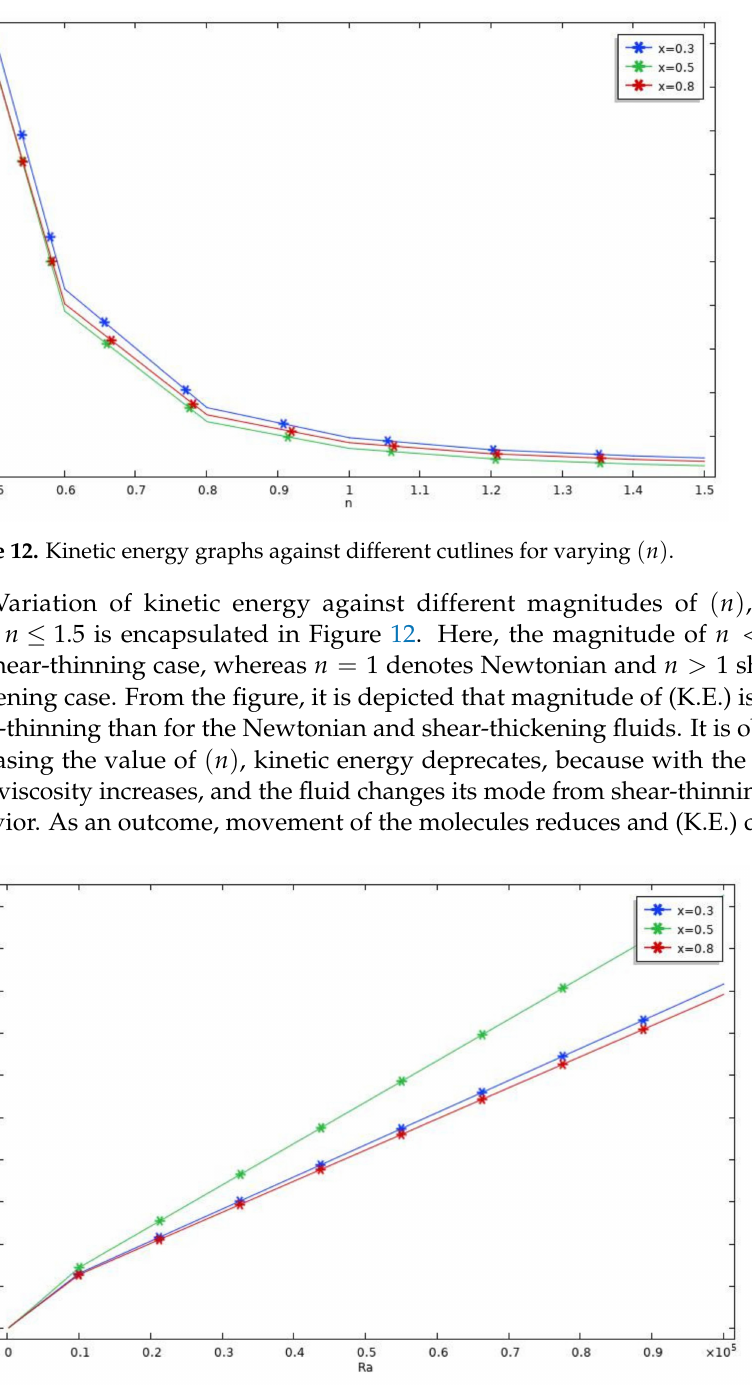
Figure 13. Kinetic energy graphs against different cutlines for varying ( Ra )